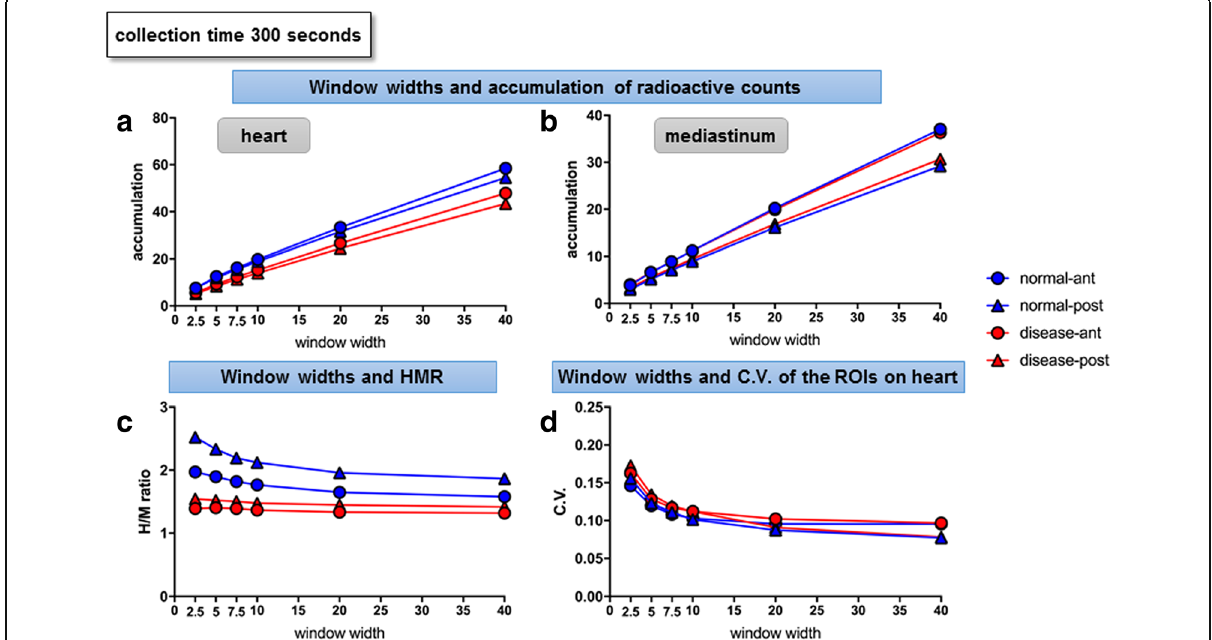
Fig. 2 Changes in parameters at different window widths (phantom study). With the collection time fixed at 300 s, the relationships between different window widths ( x -axis) and radioactive counts in the ROIs on the heart ( a ) and mediastinum ( b ), HMR ( c ), and CV of the ROIs on the heart ( d ), are shown. Blue circles — normal model, anterior view; blue triangles — normal model, posterior view; red circle — disease model, anterior view; red triangle — disease model, posterior view